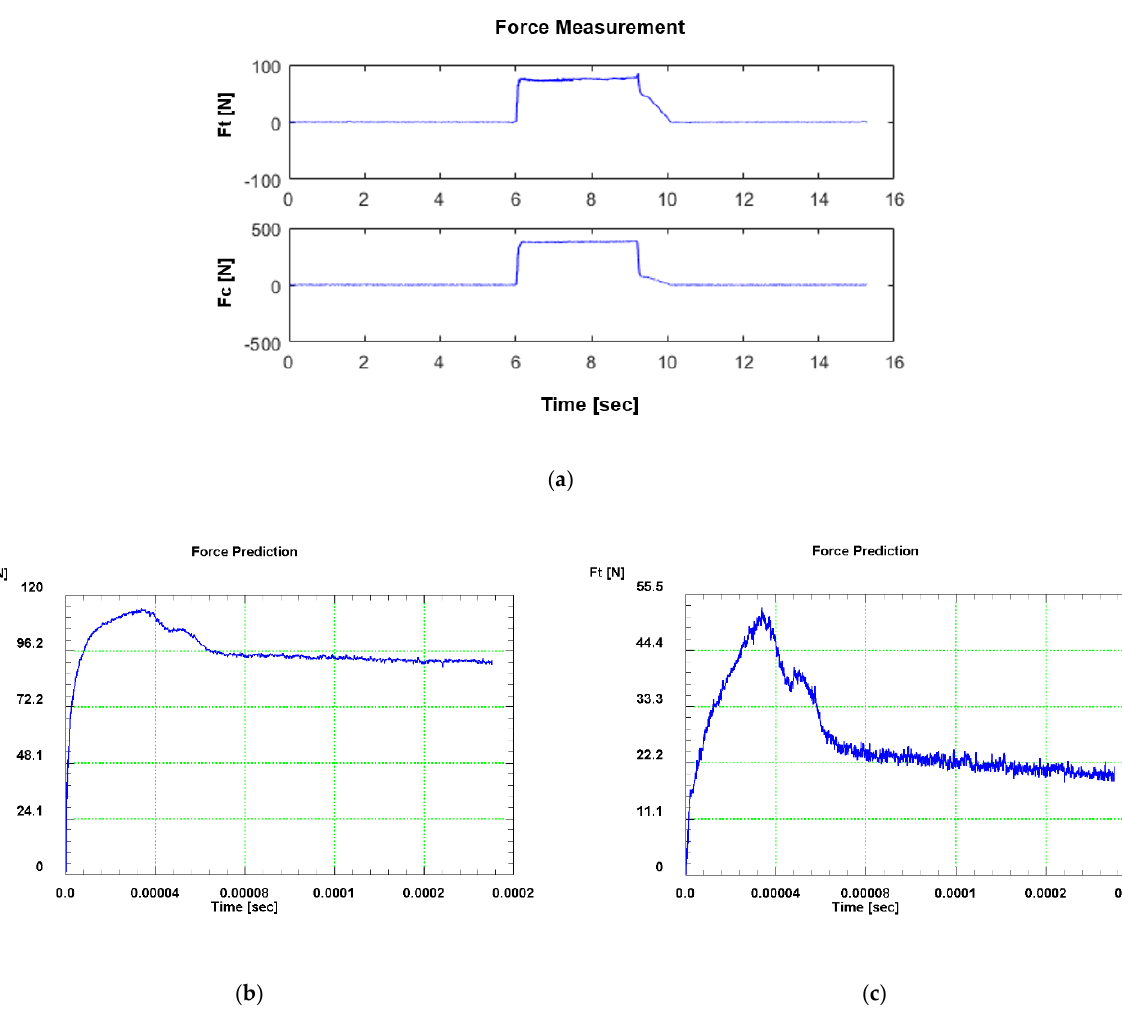
Figure 15. Variation of cutting and thrust forces with time during dry orthogonal cutting: ( a ) in the experiment (force signals) for the 4 mm width of cut and ( b , c ) in FE modeling for the unit width of cut.